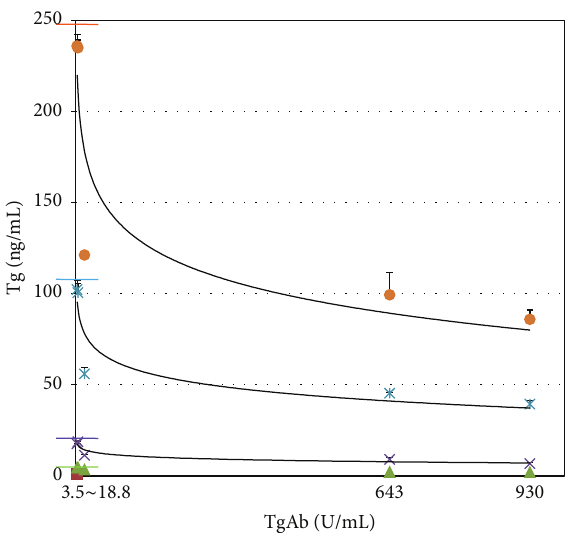
Figure 2: Measured Tg concentration in each sample produced using patients’ serum showed a proportional decline according to an increase of TgAb concentration. Transverse color bars represent expected Tg concentrations of each